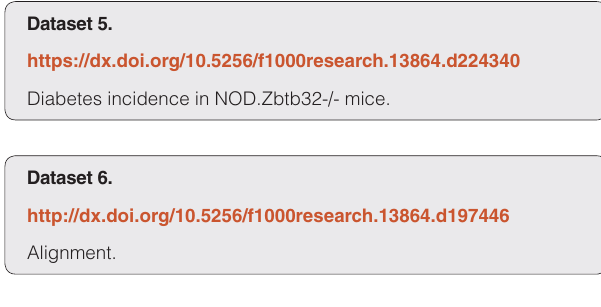
Dataset 2. Raw data for blood glucose from Figure 2 http://dx.doi.org/10.5256/f1000research.13864.d197442 The raw data values and the GraphPad Prism fole for blood glucose measurements.